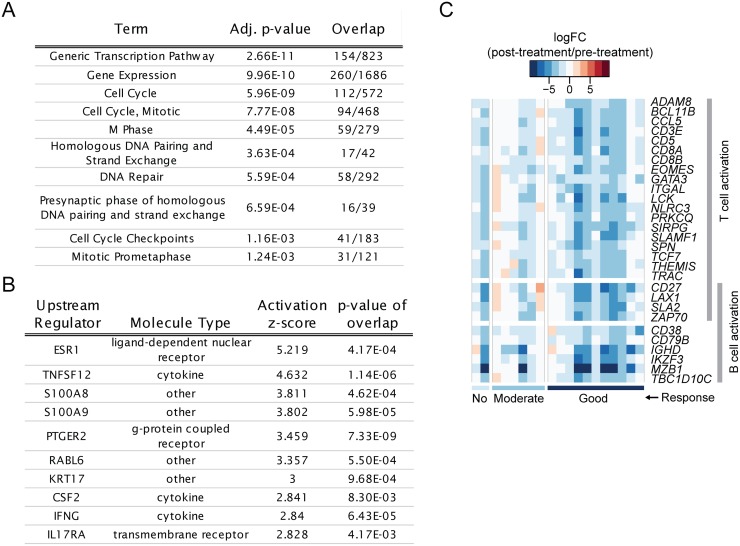
Several non-lymphocyte-related pathways remain elevated in samples from patients with LDA and lymphocyte activation genes tend to decrease more in patients with better response to tDMARDs.(A) Top ten pathway terms (Reactome database) and (B) top ten predicted activating upstream regulators (IPA database) are shown from the comparison of post-tDMARD LDA RA samples to normal samples. (C) Heatmap visualizing log(fold-changes) for each early RA subject post-tDMARD treatment compared to pre-treatment. Selected genes are those that were associated with treatment response and belonged to the “T cell activation” and/or “B cell activation” GO terms. Samples (x-axis) are ordered by EULAR response.